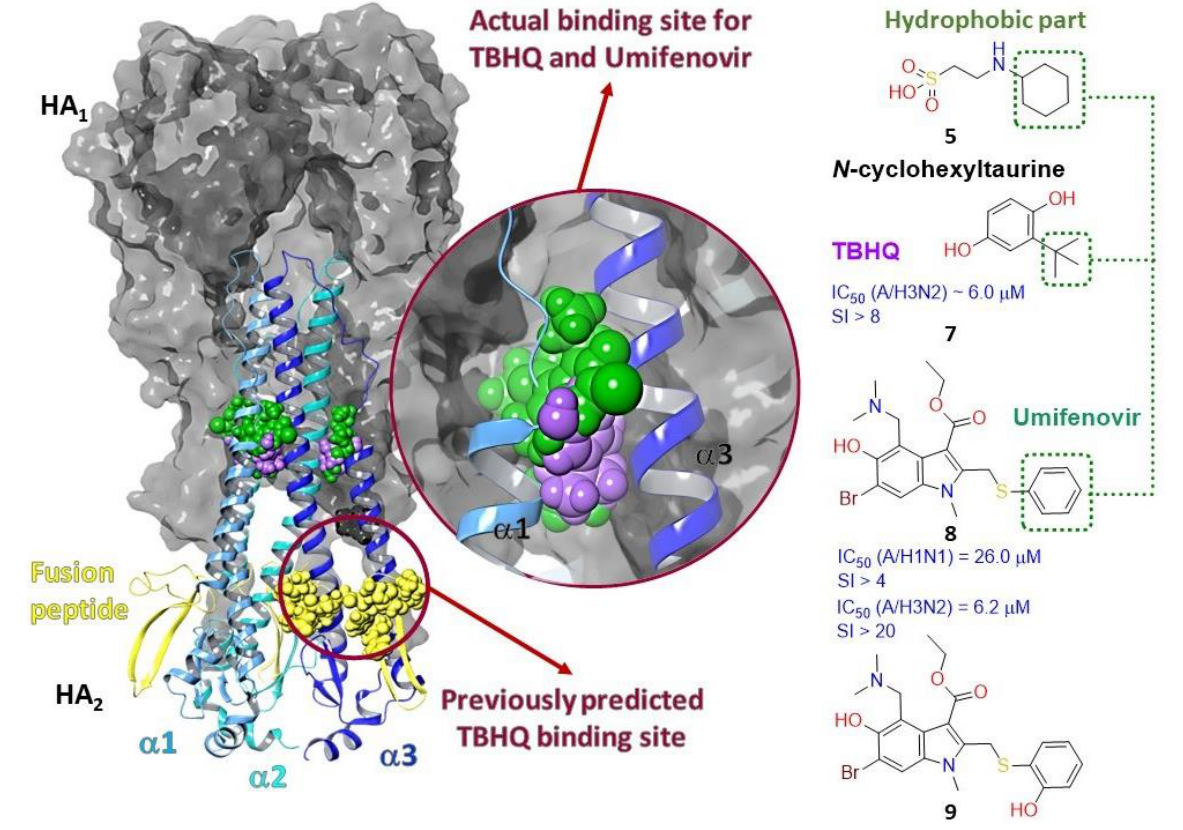
Figure 5. Binding sites of HA inhibitors.